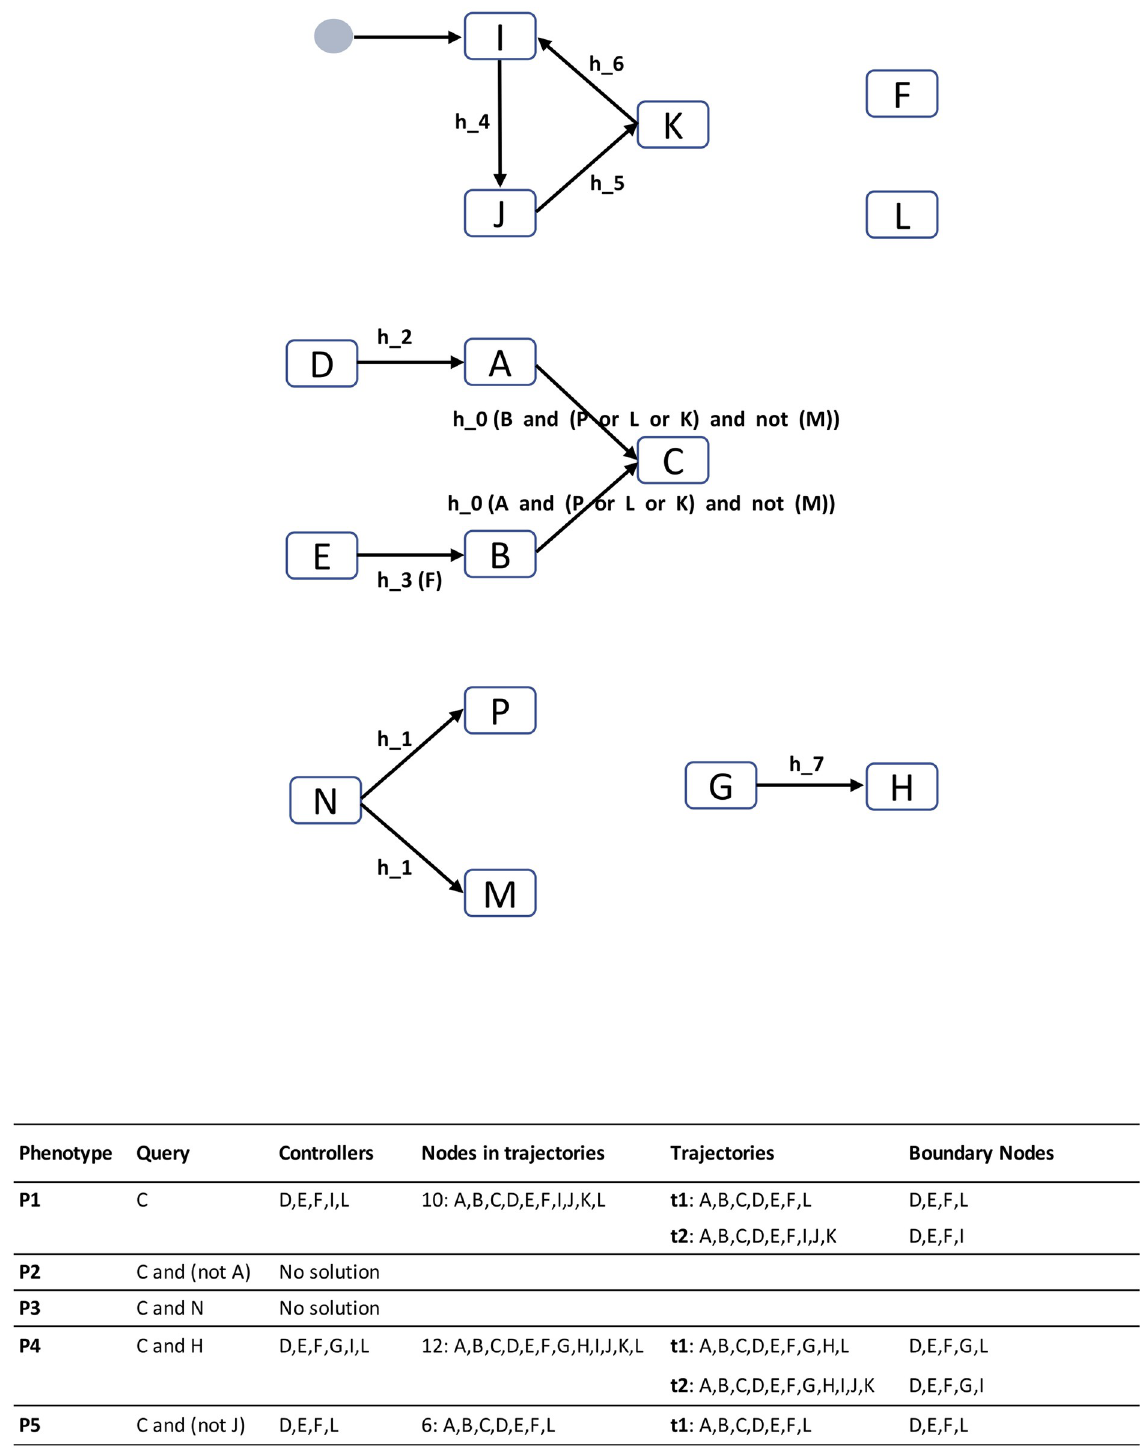
Fig 3. Example of a guarded-transition model and controllers associated with different queries. The guarded transition model consists of 15 biomolecules ( A , B , C , D , E , F , G , H , I , J , K , L , M , N , P ),11 transitions (black arrows) for 7 temporal events ( h 1 , ... h 7 ), which model reactions. Two events carry a guard (i.e., logical formula) restricting their triggering: h 0 requires the satisfiability of the formula A and (P or L or K) and not (M) , while